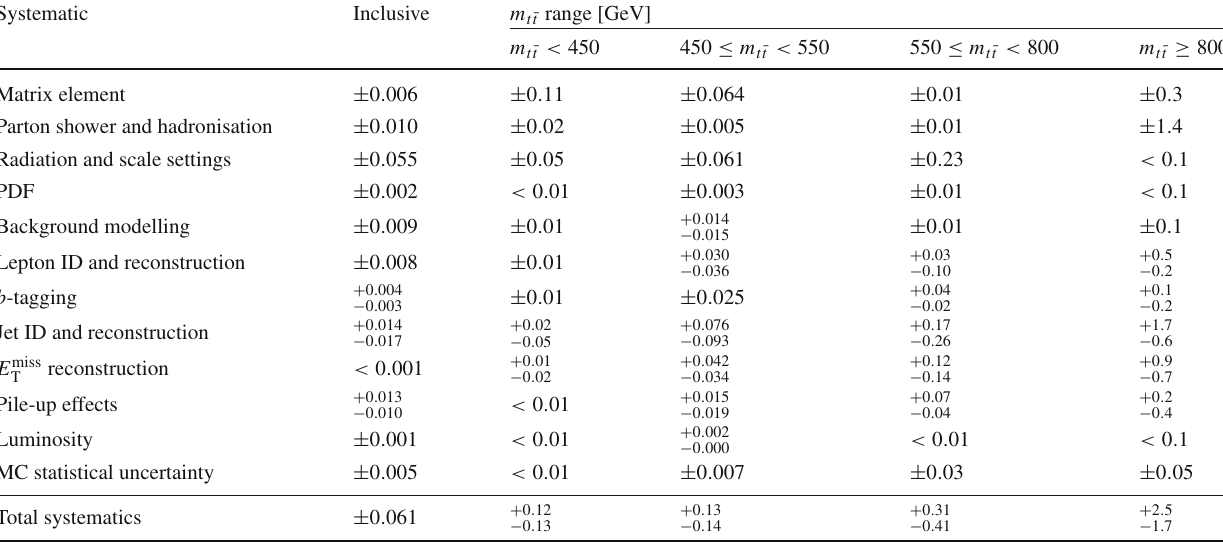
Table 5 Summary table of the effect of experimental systematic uncertainties on the f SM extraction. Uncertainties which are smaller than the precision shown are included in the totals and the f SM significance calculations